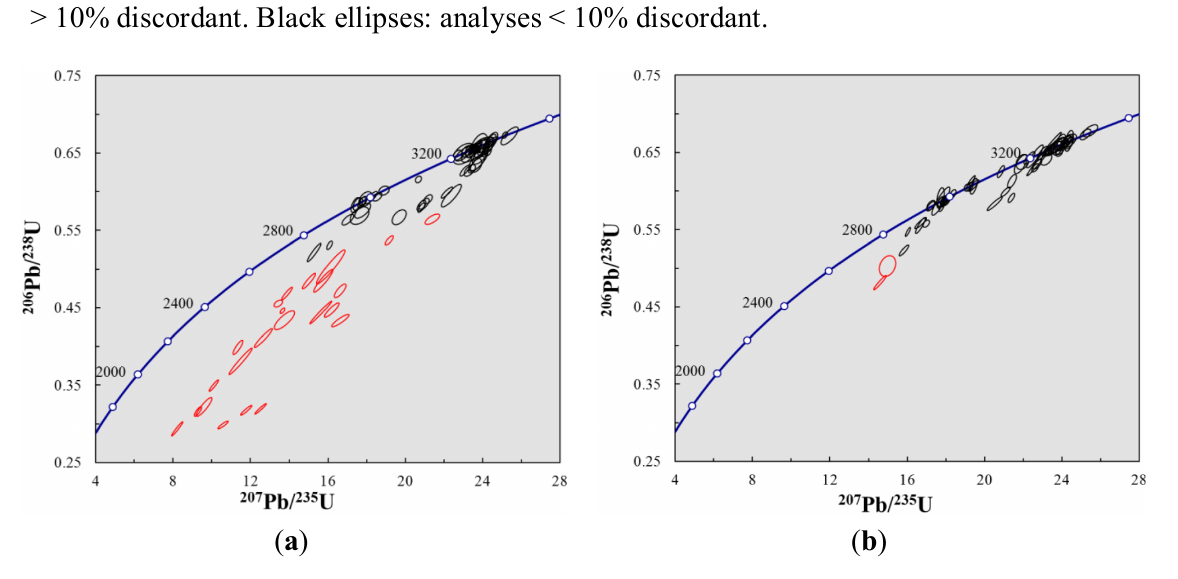
Figure 6. Chemical and age data for sample TSUPB021: ( a ) U ppm vs. 207 Pb/ 206 Pb age